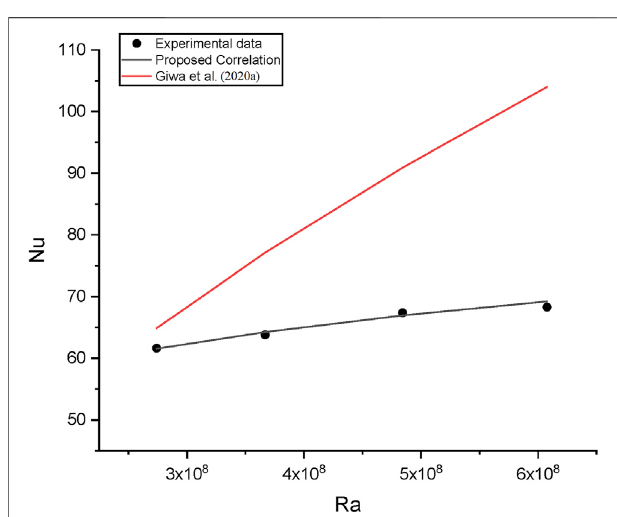
FIGURE 11 | Variation of Predicted average Nu with experimental average Nu. FIGURE 12 | Comparison of developed correlation with existing